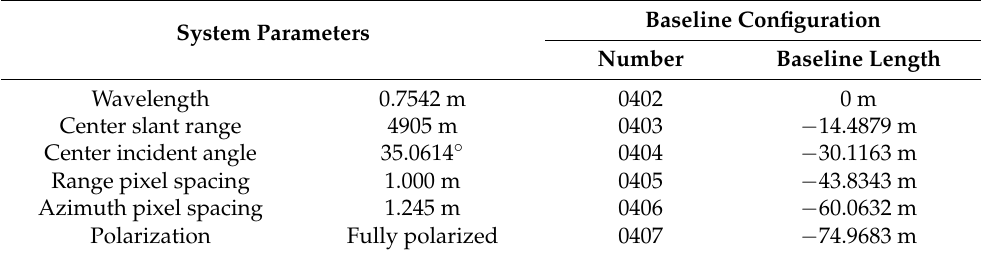
Table 2. System parameters and baseline configuration of TropiSAR2009 data set.